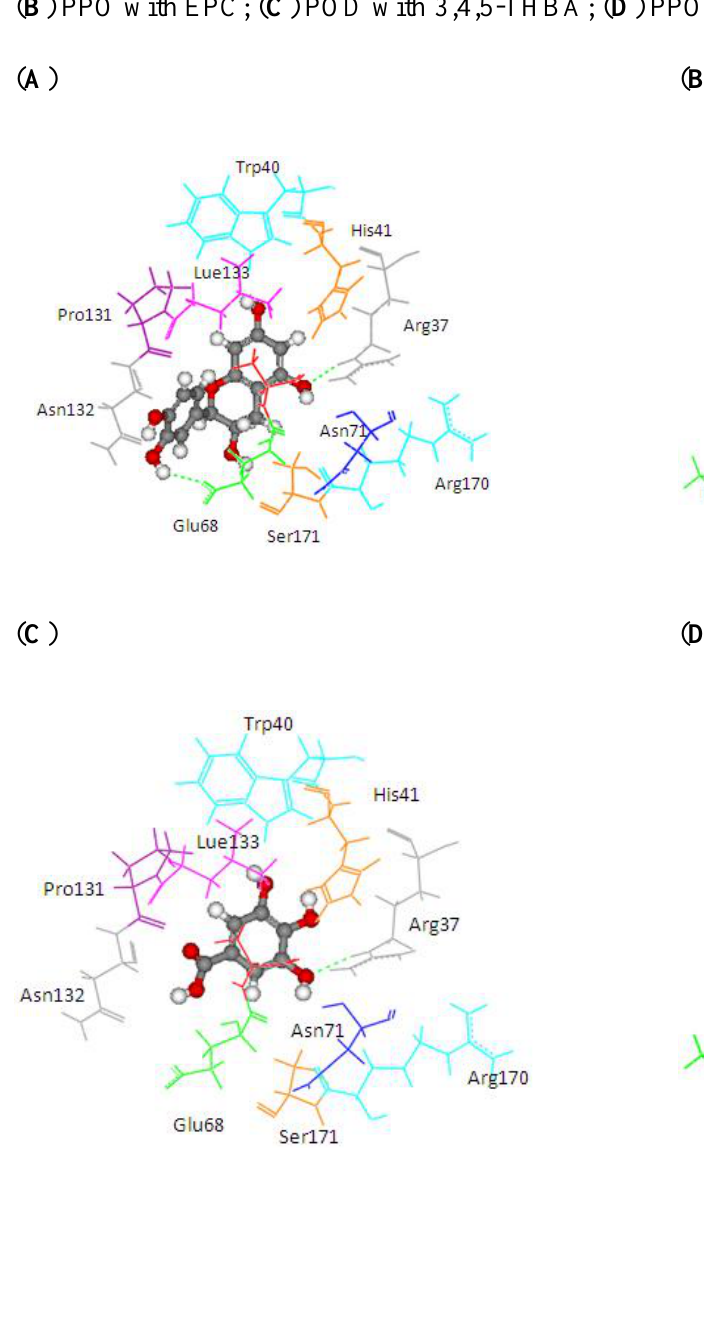
Figure 3. 3 Å binding site comparison of PPO and POD with common substrate and inhibitor (in ball and stick model). Dashed line represents H-bond. ( A ) POD with EPC; ( B ) PPO with EPC; ( C ) POD with 3,4,5-THBA; ( D ) PPO with